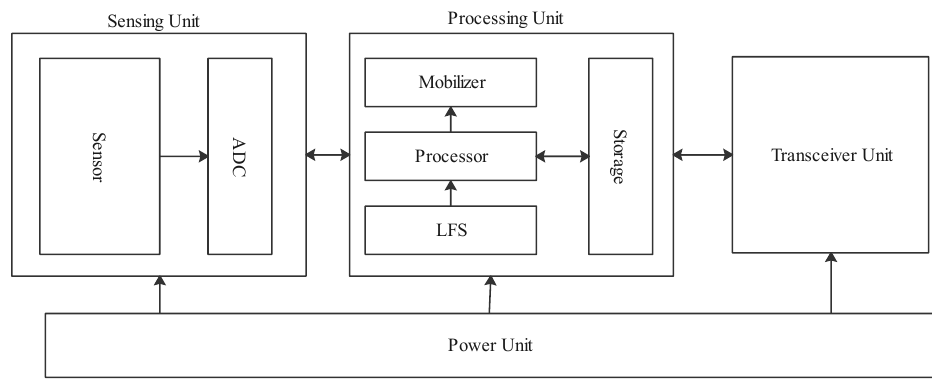
Figure 3. A detailed representation of the four units of an IoT